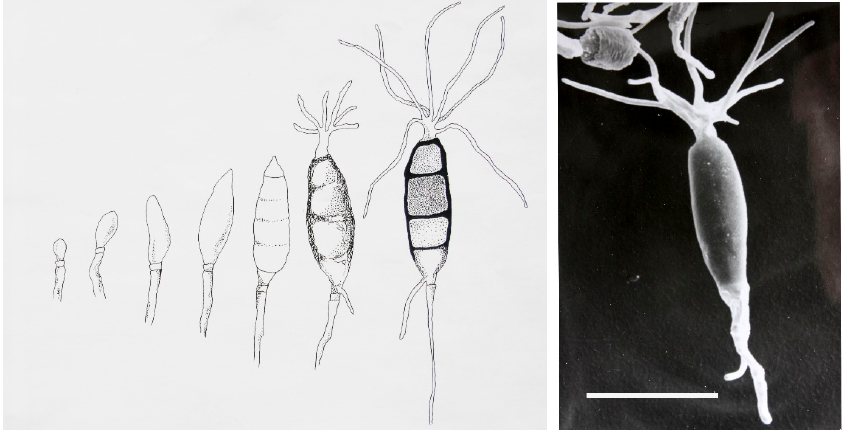
Figure 1. Development of the conidiospore of Seimatoanlerium tepuiense a novel endophyte discovered on a tepui in the Brazil, Venezuela, Guyana area of South America. The actual spore is shown to the right as a scanning electron micrograph. The bar is equivalent to 20 microns.